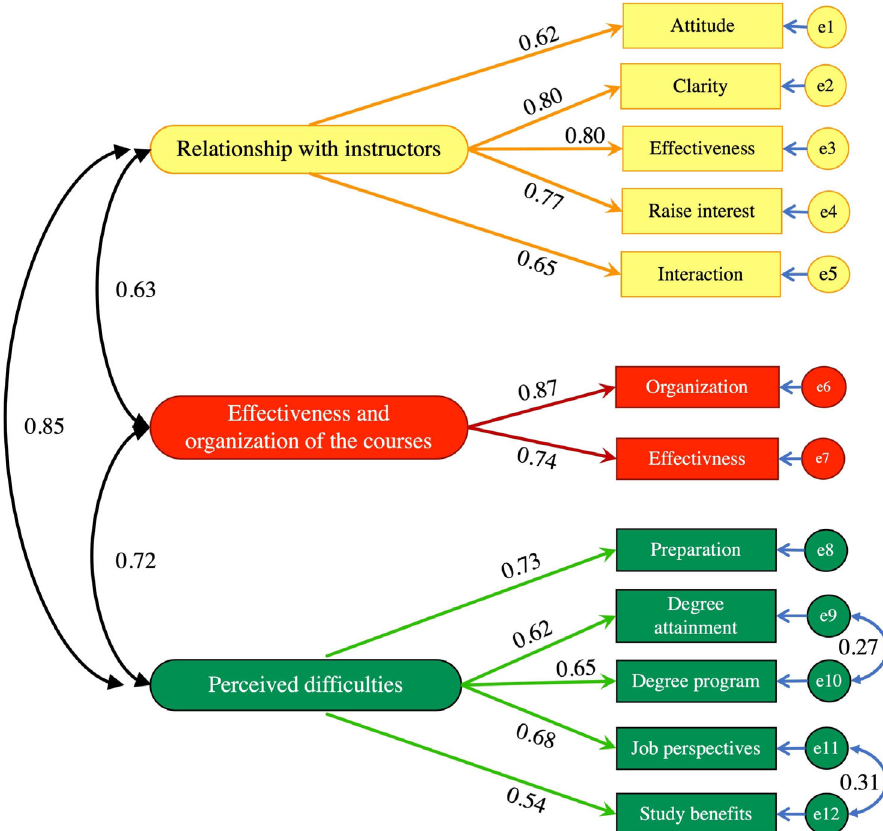
FIG. 1. Factor structure of the perception of emergency remote instruction. The unobserved constructs ( factors ) are represented by rounded rectangles. The observed variables (i.e., the questionnaire items) are represented by rectangles. The single-headed arrows represent structural regression coefficients, namely, the factorial loads of an observed variable onto the factor. The measurement errors associated to observed variables are represented by a circle and a small single-headed arrow near the corresponding variable. Two- headed black arrows represent the covariances of the constructs, while two-headed blue arrows represent the error covariances of the items ( modification indices ).